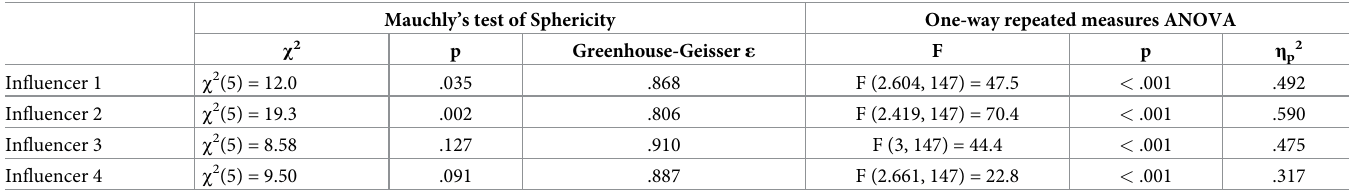
Table 1. Results of the pretest. Mauchly’s test of Sphericity One-way repeated measures